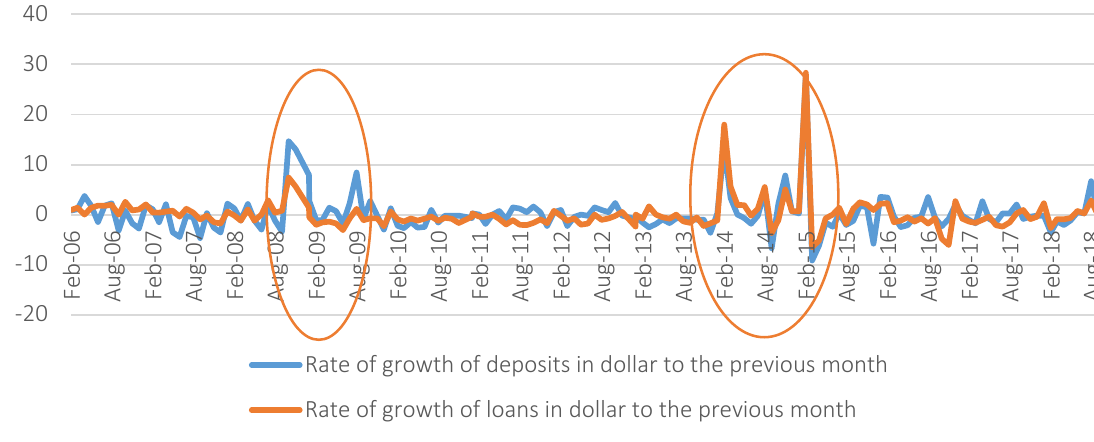
Figure 7. The dollarization level of loans and deposits of residents, 2006–2018,